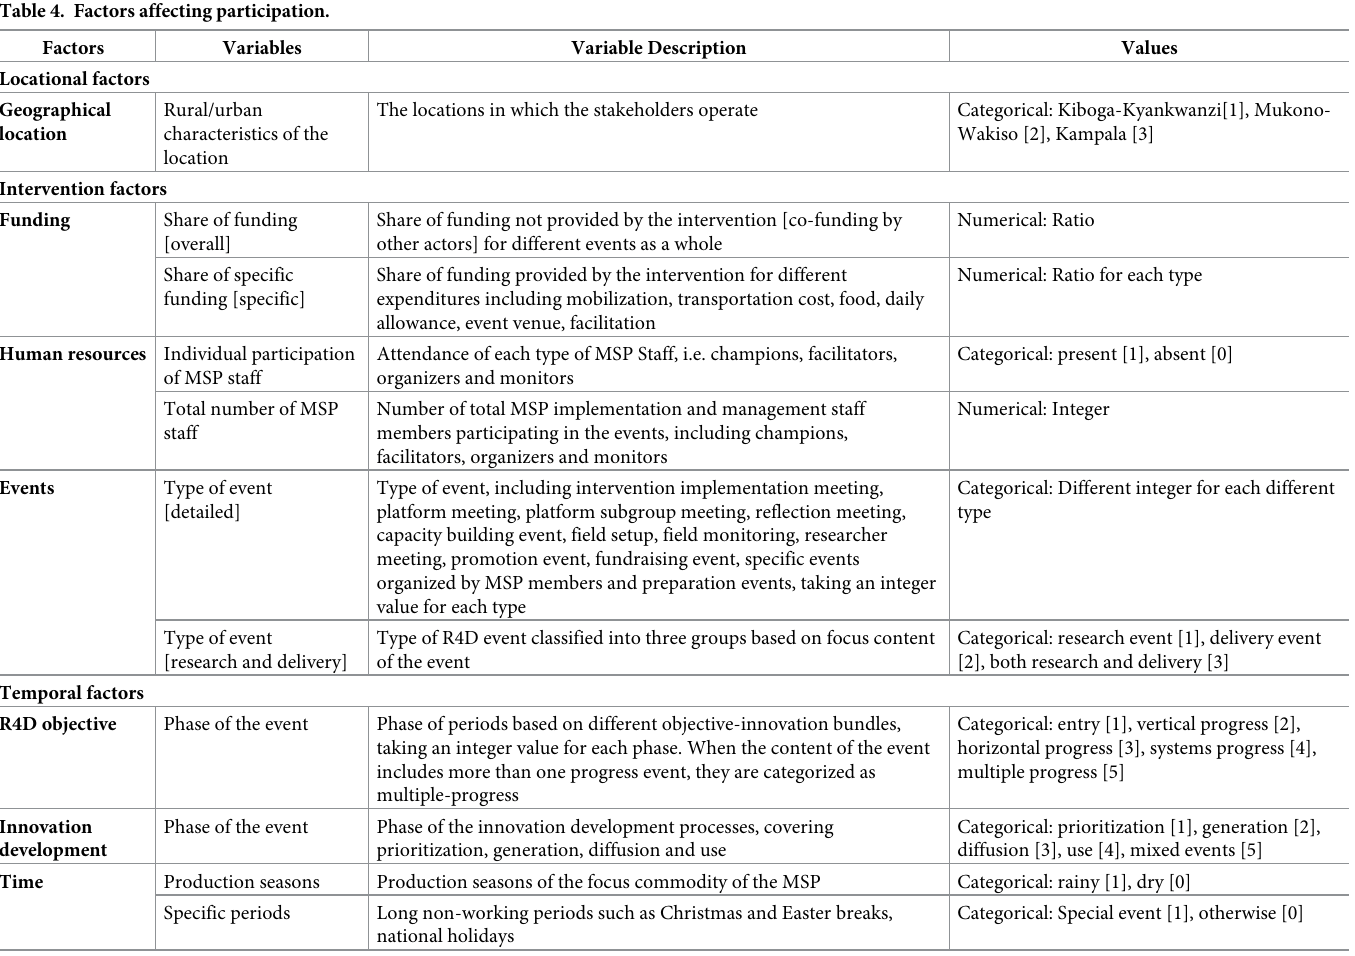
Table 4. Factors affecting